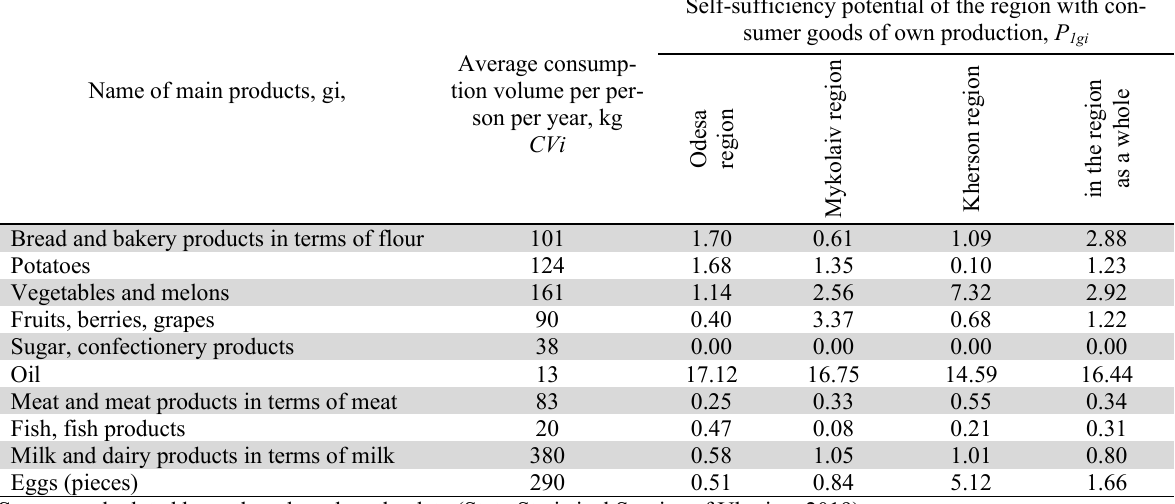
Self-sufficiency coefficients of the Black Sea region with basic food products in 2018